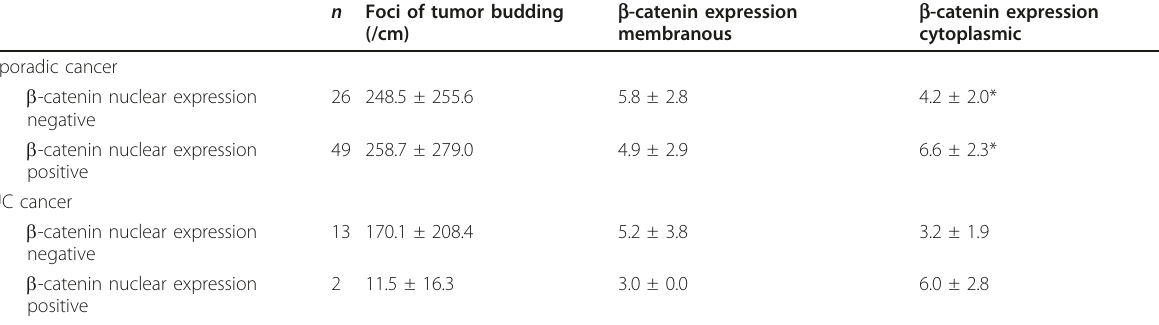
Table 6 Relation among beta-catenin expression and tumor budding